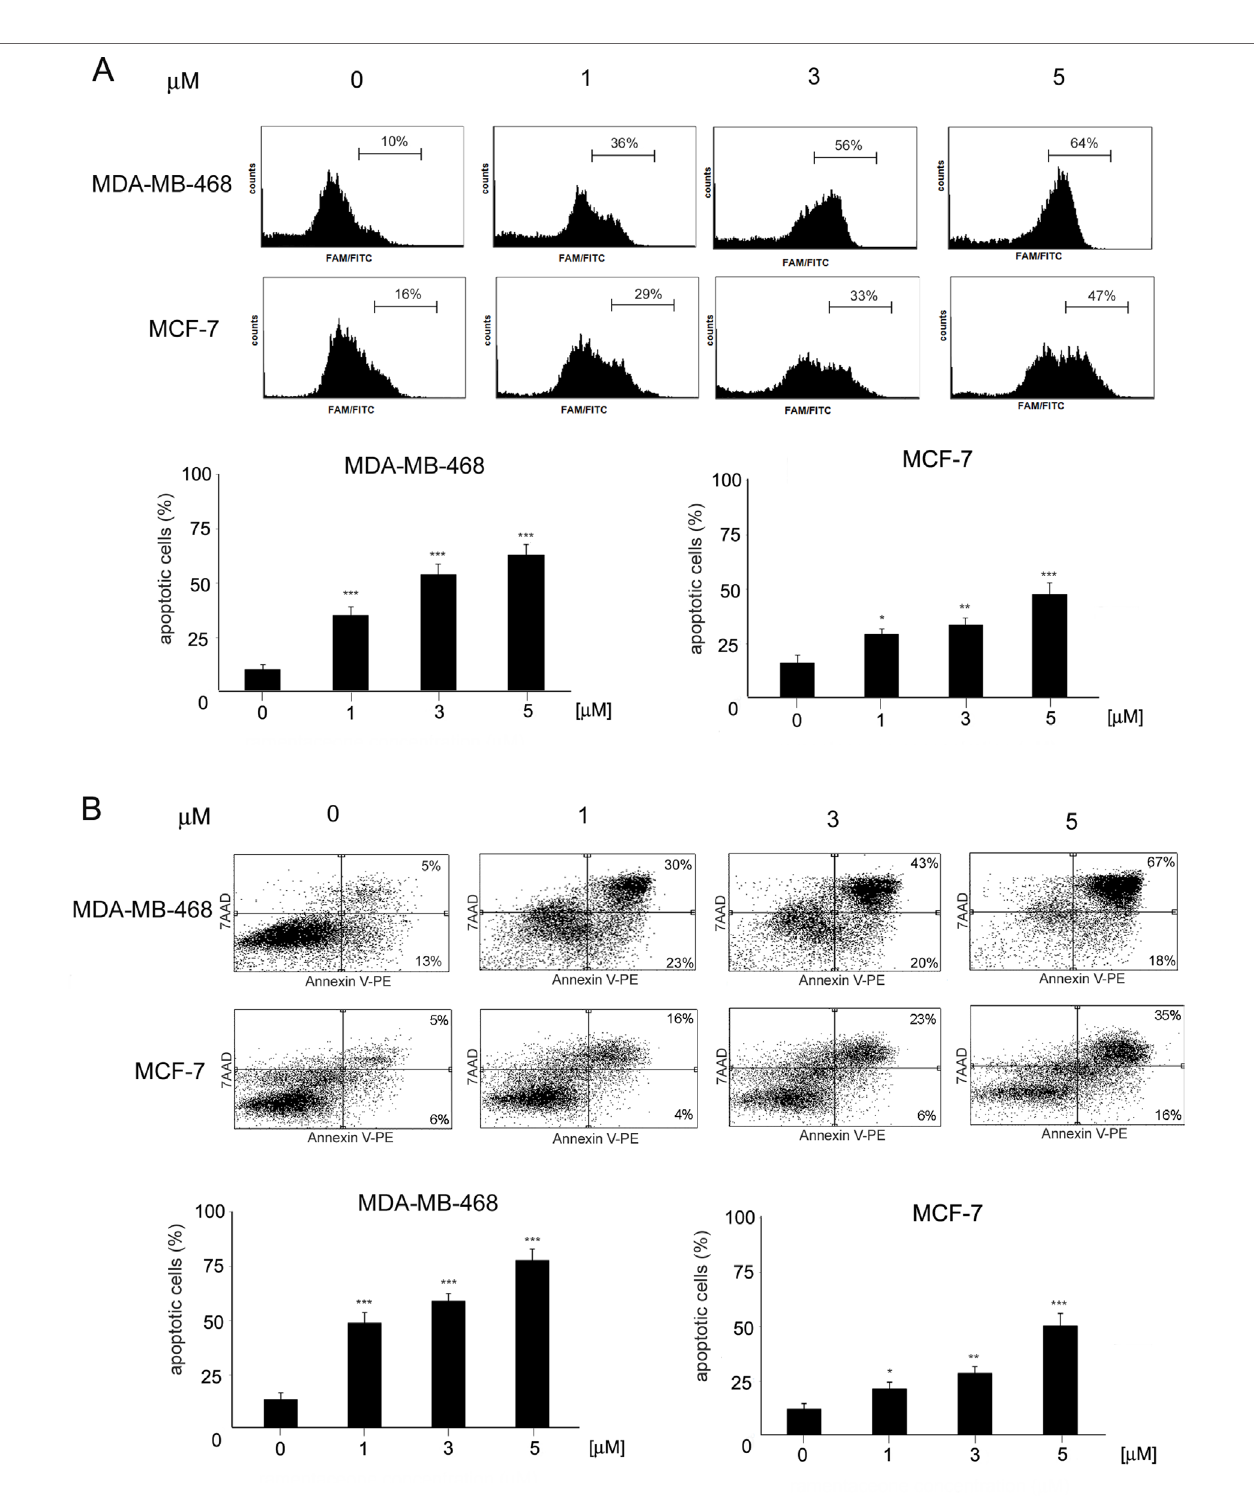
FIGURE 2 | Induction of apoptosis by 3-chloroplumbagin in breast cancer cells. (A) Induction of caspase activity by ChPL. Analysis was performed with flow cytometry with the use of a caspase inhibitor, FAM-VAD-FMK (B) Apoptotic changes in plasma membrane induced by ChPL. Analysis was performed with flow cytometry after Annexin V-PE/7-AAD staining. Data were analyzed by one-way ANOVA with Tukey’s post hoc tests [ p < 0.05 (*), p < 0.01 (**), p < 0.001 ( *** ), n =